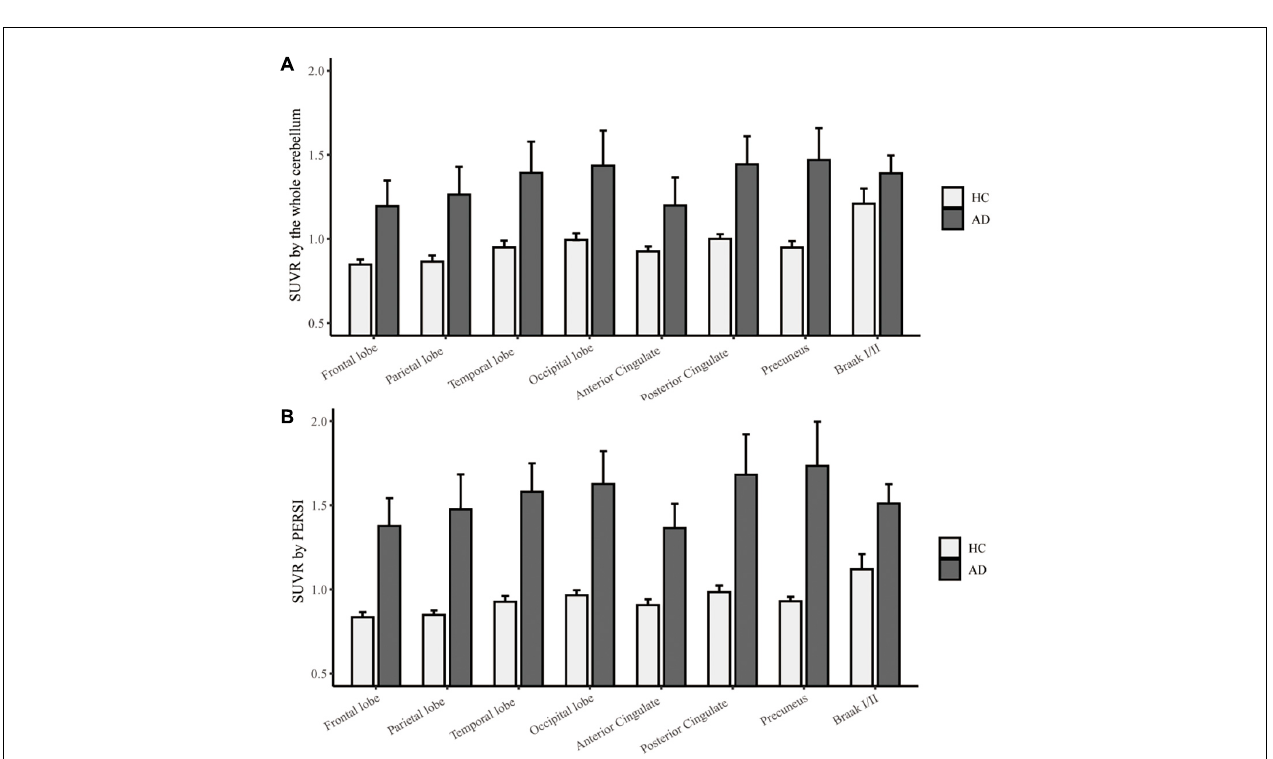
FIGURE 3 | Regional [ 18 F]-APN-1607 SUVR count normalization. (A) The whole cerebellum was the reference region for quantification. (B) PERSI-WM for HC and AD groups. Mean group SUVRs ( ± SD) across predefined ROIs are